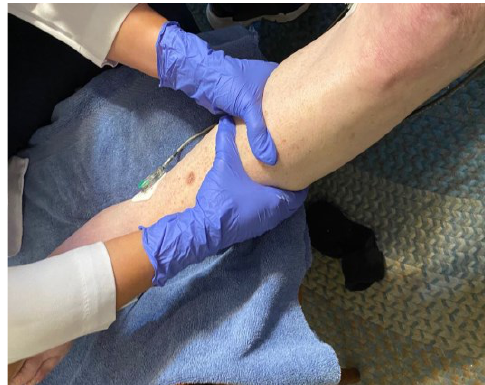
Figure 2. Position of hands during DTM.